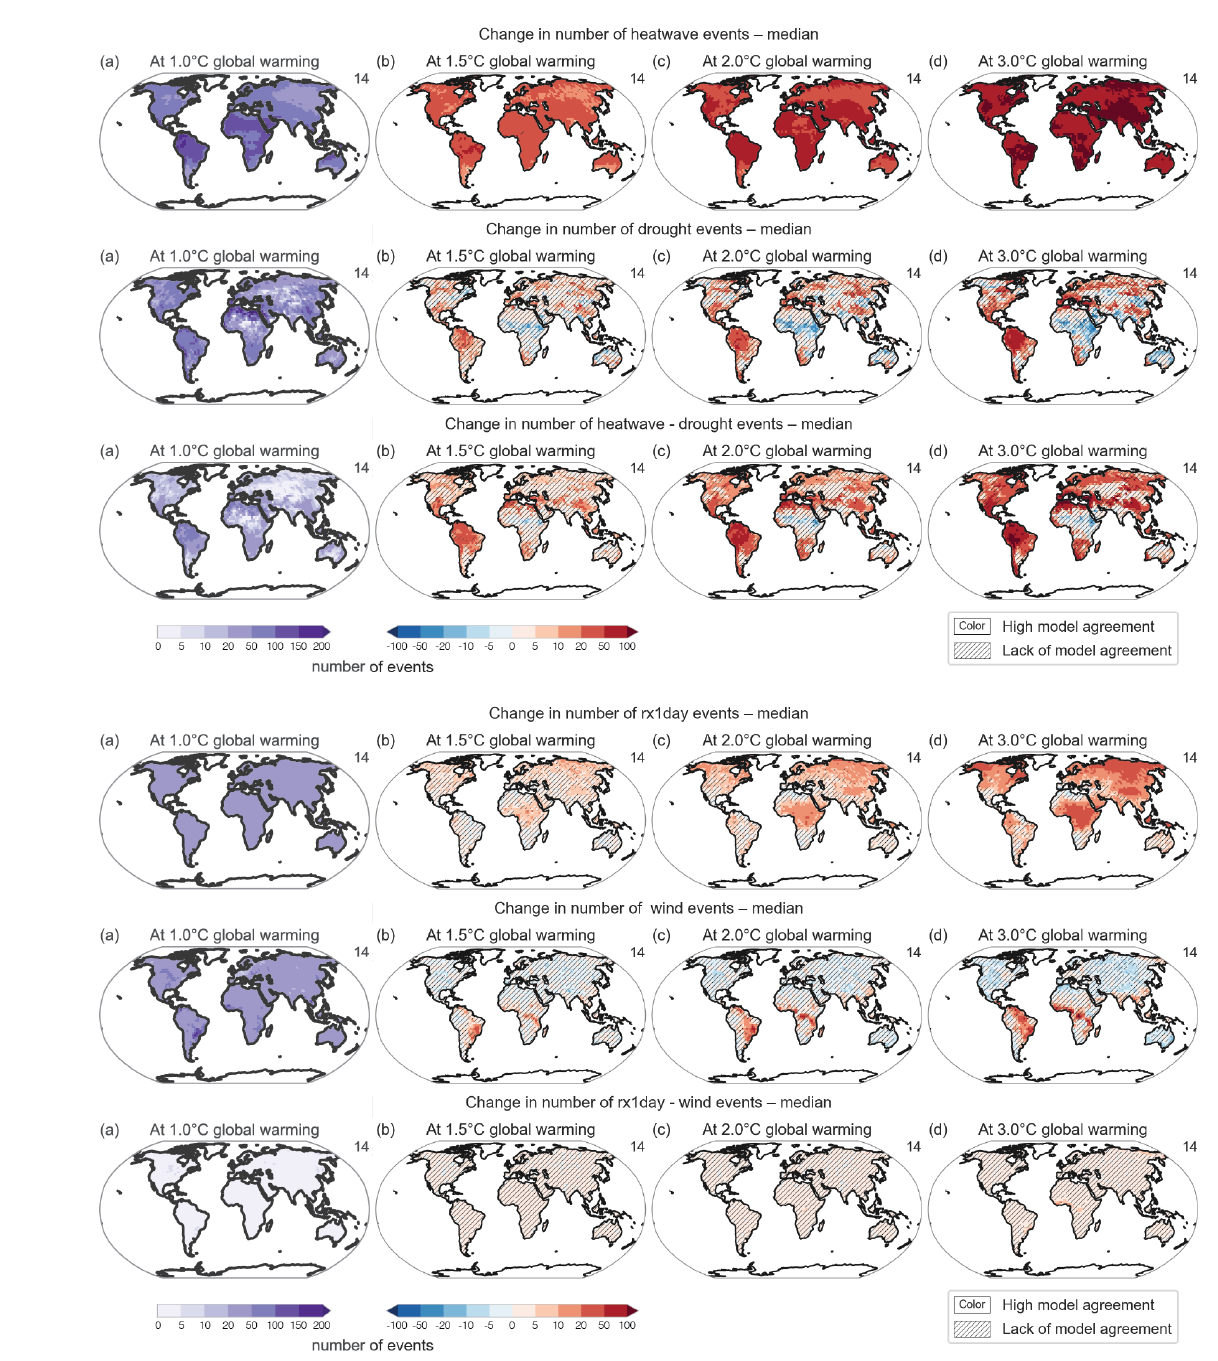
Figure B2. Number of individual and concurrent extremes (a) at + 1 ◦ C and (b, c, d) change at + 1.5, + 2 and + 3 ◦ C with respect to + 1 ◦ C. Colours refer to high model agreement, and hatched areas refer to lack of model